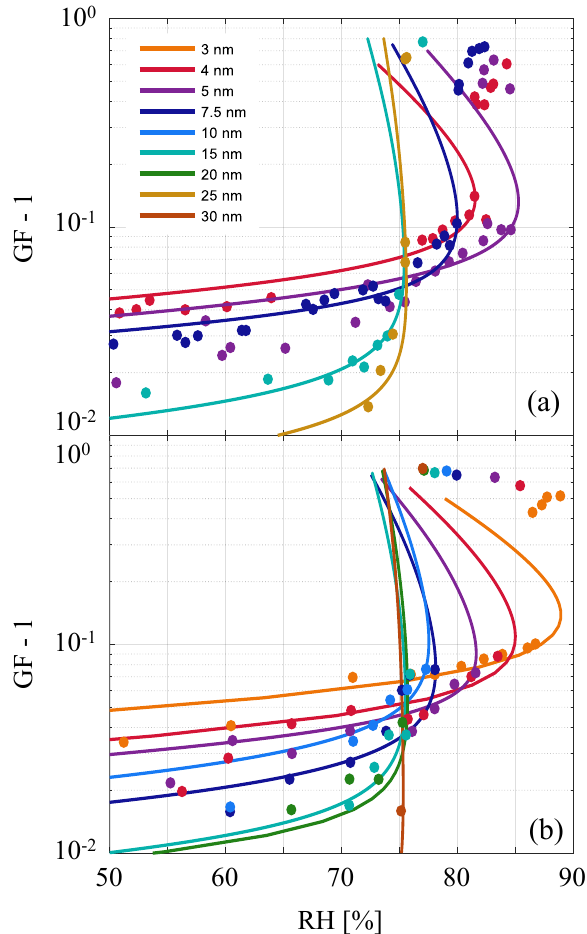
Figure 4. Measurement data points of NaCl particle hygroscopic growth under incrementally increasing RH. Colors correspond to different initial dry particle radii indicated in the legend and the growth factor (GF) is the ratio of the measured radius to the dry radius (GF-1 scaling is used to suitably present data on logarith- mic scales). (a) Lines represent theoretical fits to data presented by Hämeri et al. (2001). (b) Theoretical fits to data presented by Biskos et al. (2006). In all cases fitting parameters are presented in Table 1. Given the experimentally prescribed increasing humidities, particles that grow beyond the activation barrier set by the strong Kelvin effect (cf. Fig. 5) are observed at RH exceeding the equilib- rium value.